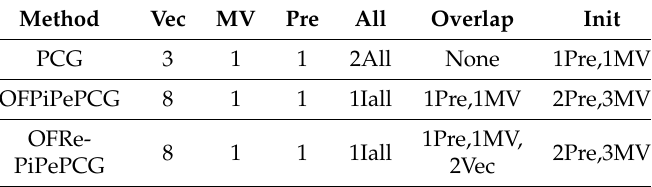
Table 3. Comparison of the PCG algorithm.